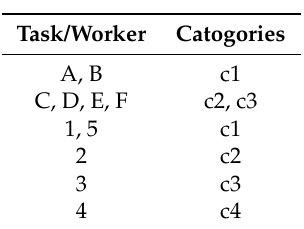
Table 1. Task/worker